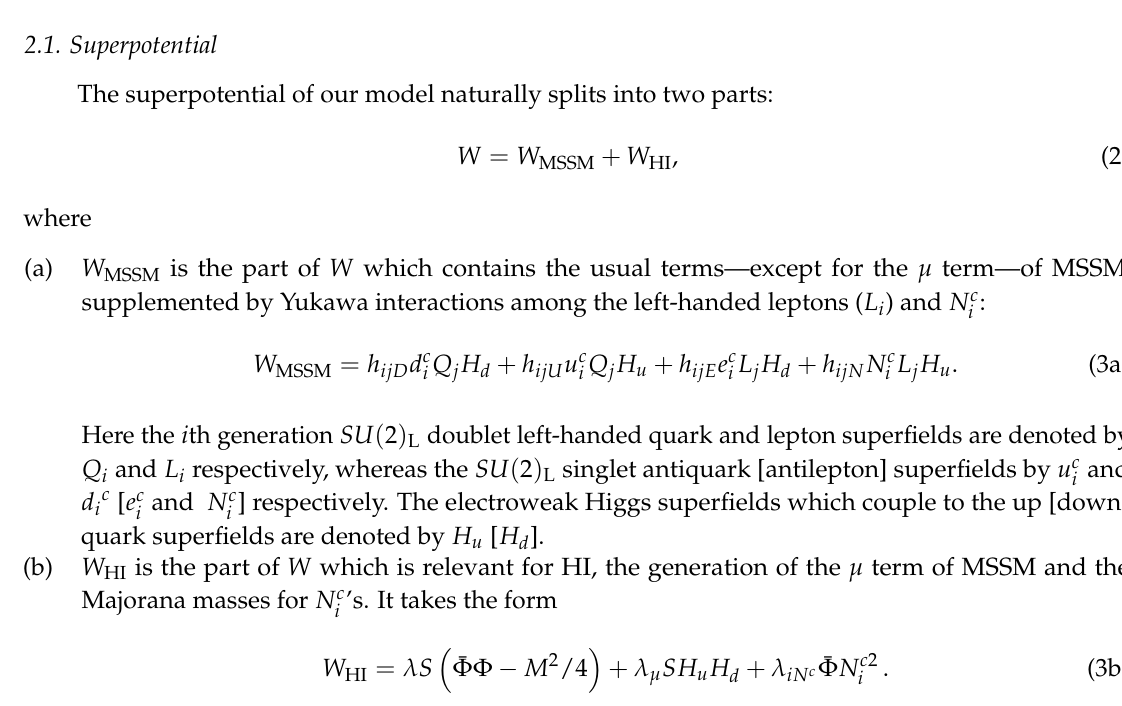
Higgs Fields ( 1 , 2 ,1/2,0